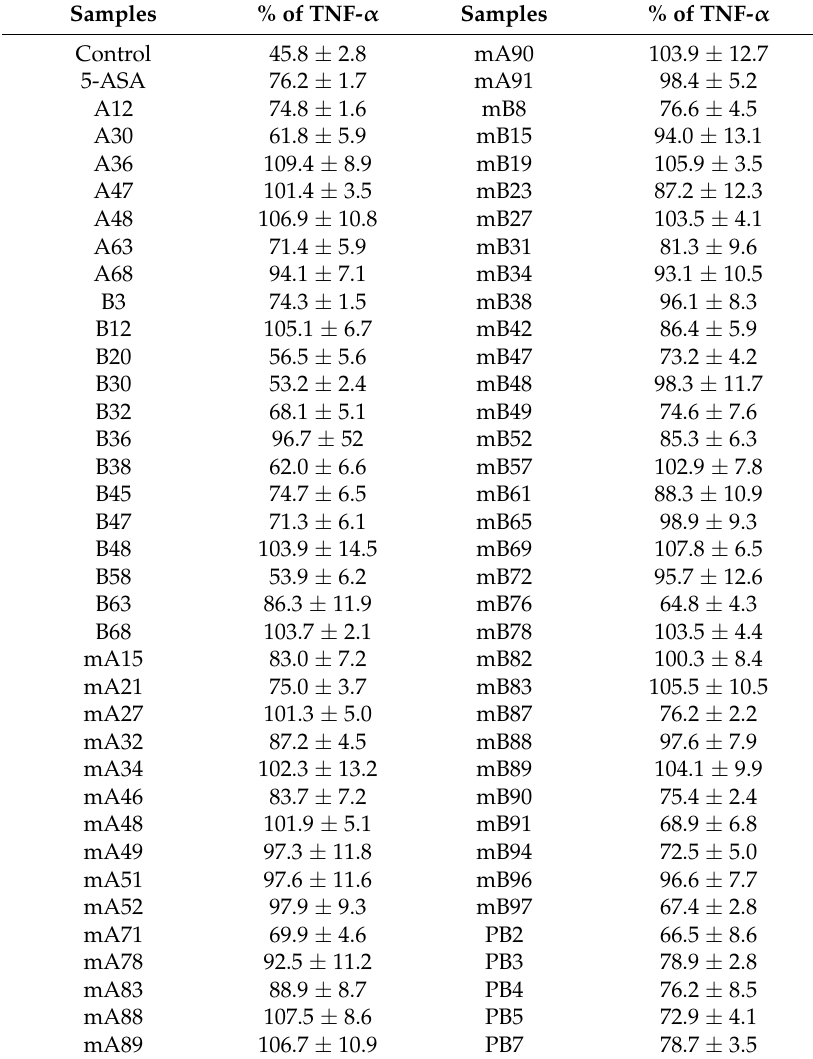
Table 4. Inhibitory effects of the selected 72 samples against TNF- α induced